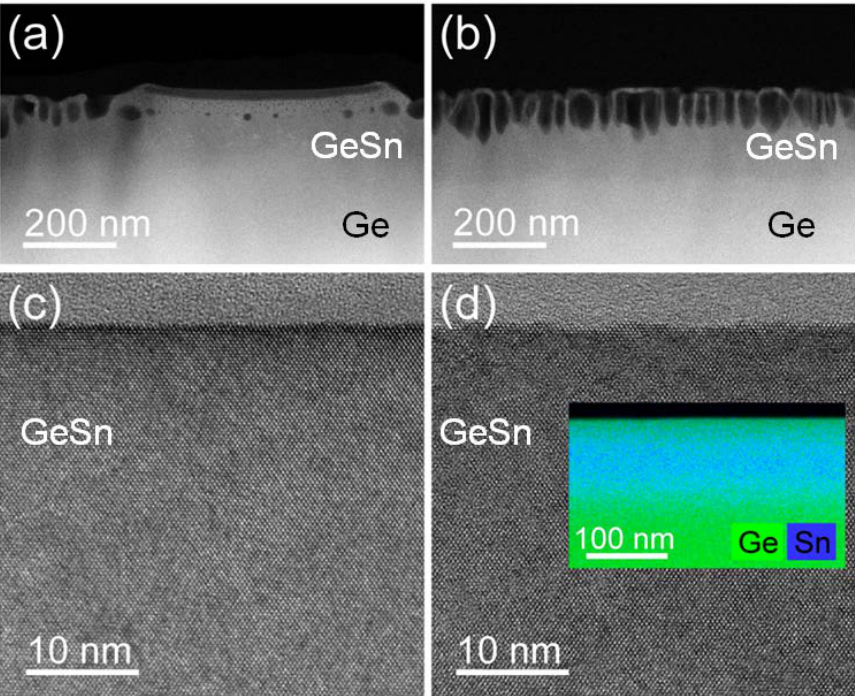
Figure 3. ( a ) and ( b ) show cross-sectional scanning transmission electron microscopy (STEM) images obtained from the samples presented in Figure 1( b ) (fluence: 2.8 × 10 15 cm − 2 ) and ( c ) (fluence: 4.2 × 10 15 cm − 2 ) for the island region and next to it, respectively. ( c ) shows a cross-sectional high-resolution TEM image obtained from Sn-implanted Ge (fluence: 2.8 × 10 15 cm − 2 ) without capping layer after PLM and ( d ) shows a high-resolution TEM image of a Sn-implanted sample (fluence: 1.2 × 10 16 cm − 2 , energy: 200 keV) with SiO 2 capping layer and with low ion flux after FLA. The inset in ( d ) shows the Sn distribution (blue color) in Ge (green color) based on energy-dispersive X-ray spectroscopy (EDXS) analysis in scanning TEM mode.